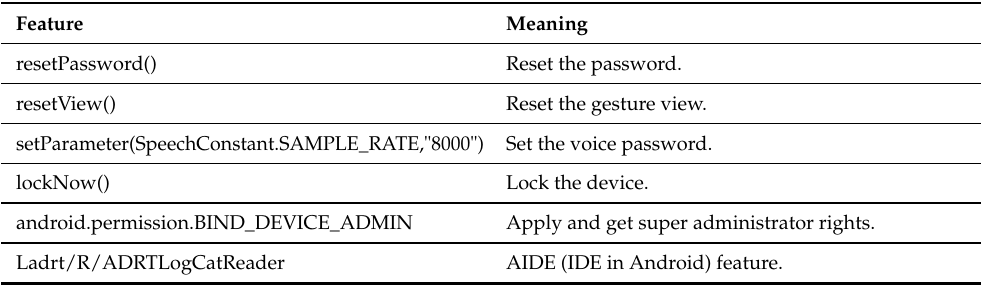
Table 1. Typical features of device lock ransomware applications.